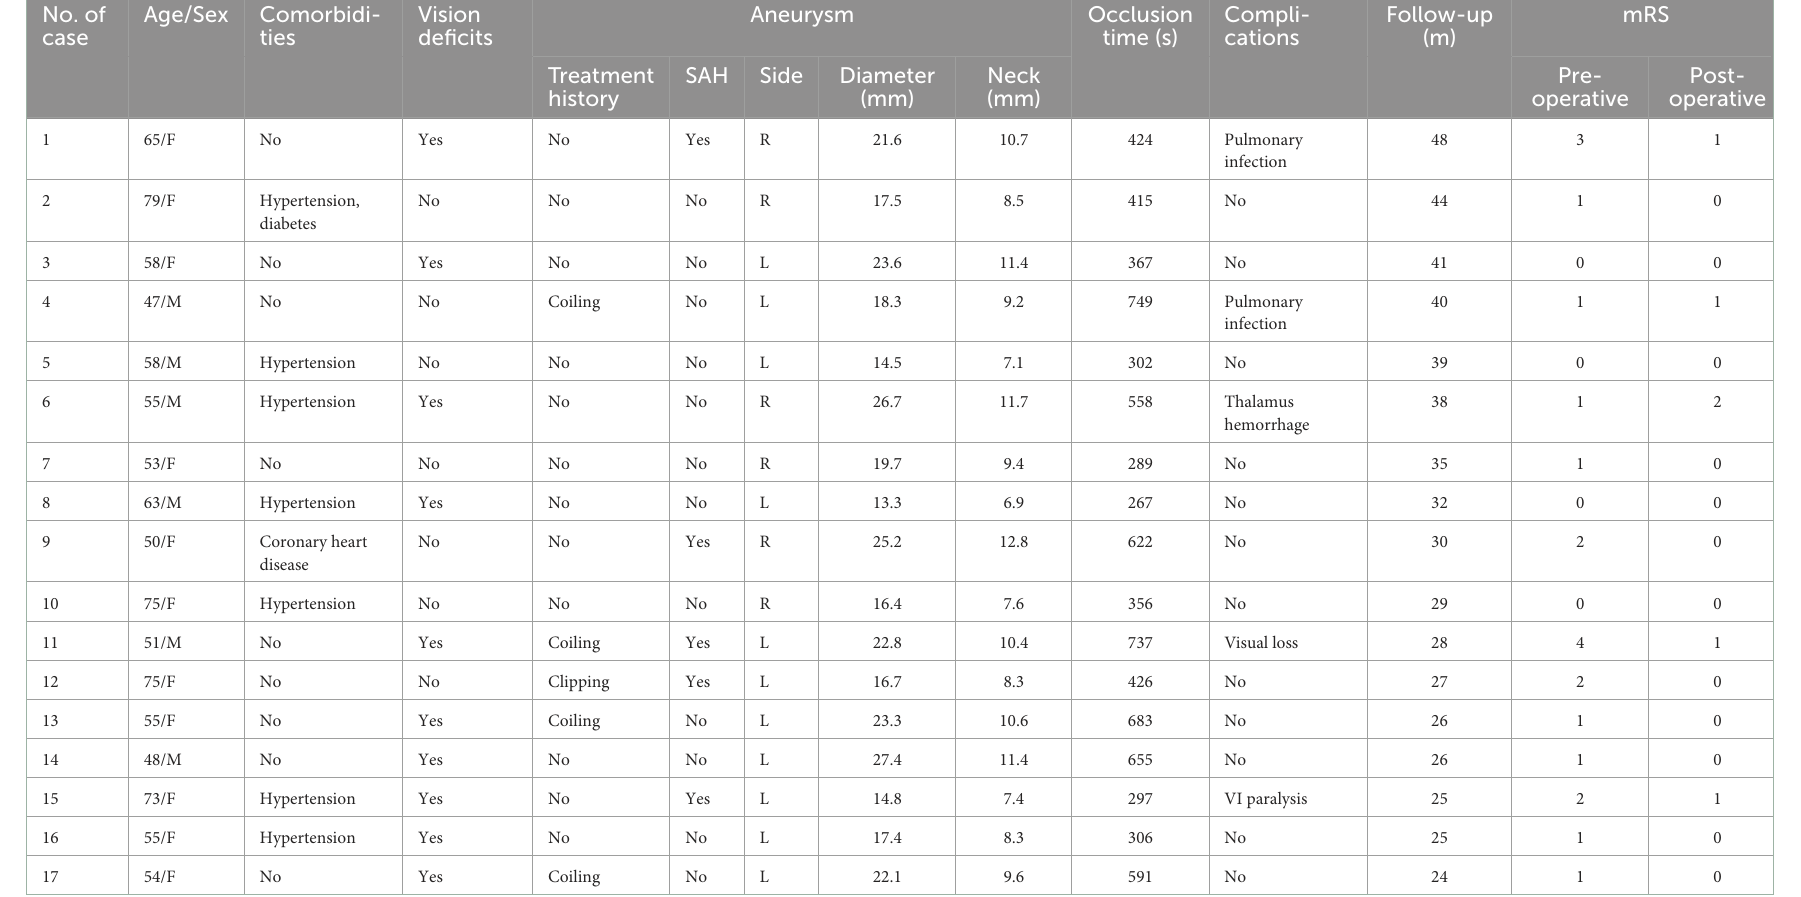
TABLE 1 Summary of patient and aneurysm